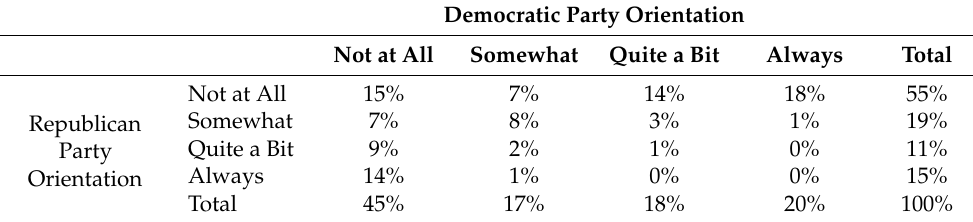
Table 1. Political party orientation.